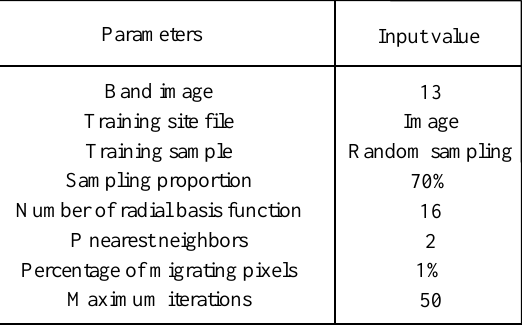
Table 4. Input parameters for implementing